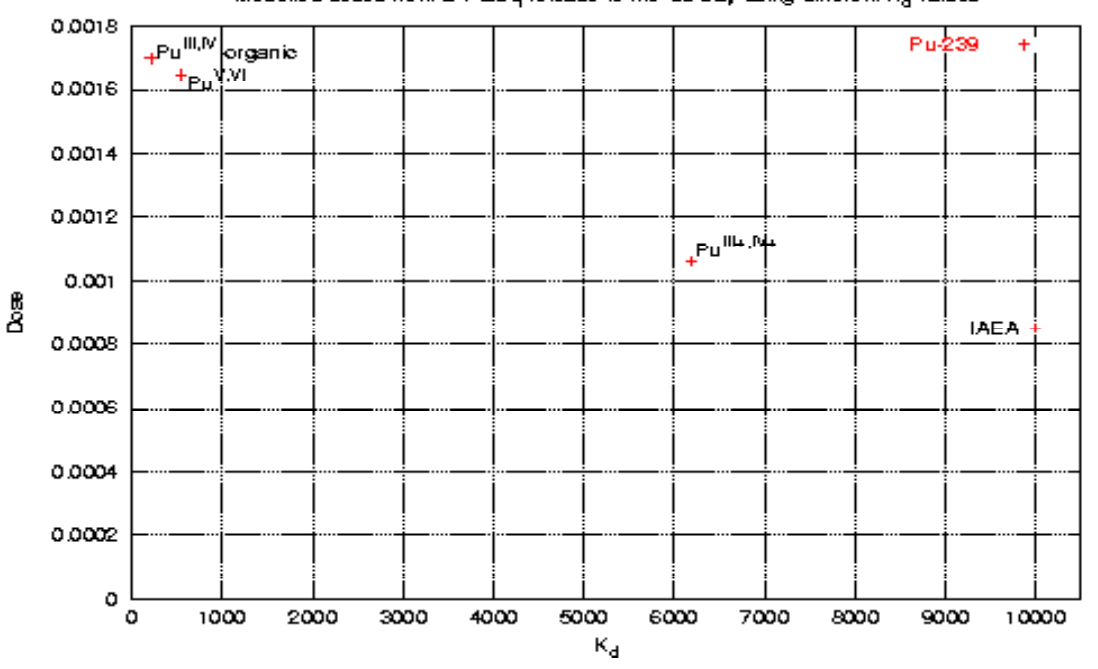
FIGURE 14 . Modelled doses from a 1 GBq released to the Ob Bay using the different K D s for the different Pu species after a contact time of 6 months. K D s are given in l/kg and doses are given in manSv[15].